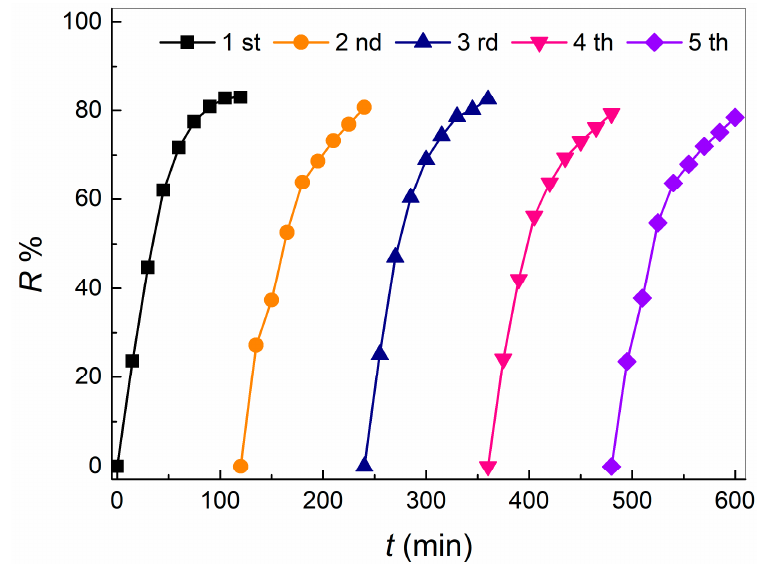
Figure 8. Reuse performance of composite nanofiber membrane in catalytic oxidation degradation of TC.